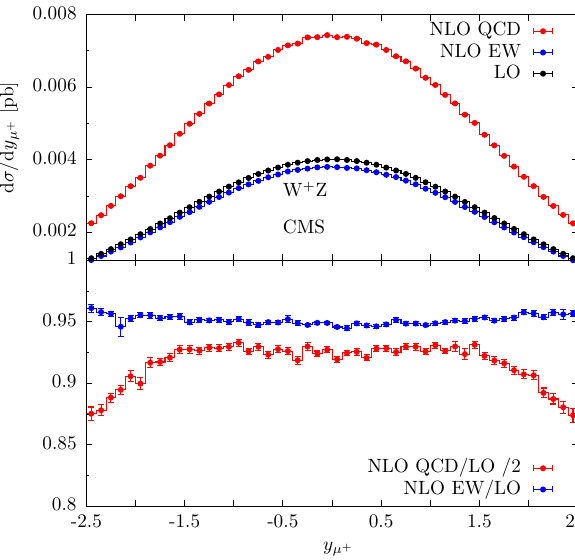
Fig. 12 Differential distribution in the positron and antimuon rapidi- ties ( y e + and y μ + , respectively) for the process pp → e + ν e μ + μ − at √ s = 13TeV under the event selections of Eqs. (4.7) and (4.8). Note